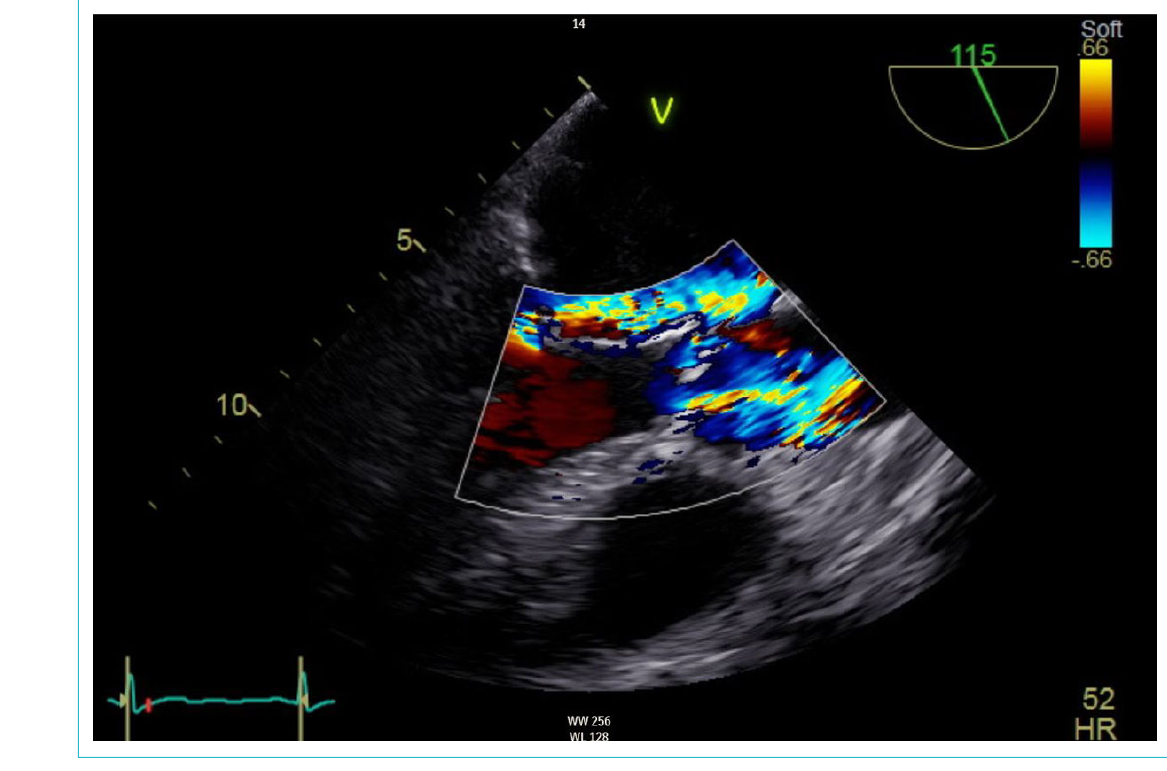
Figure 1: Severe mitral valve regurgitation with partial flail of the posterior mitral valve leaflet and moderate aortic valve stenosis. Preoperative transoesophageal